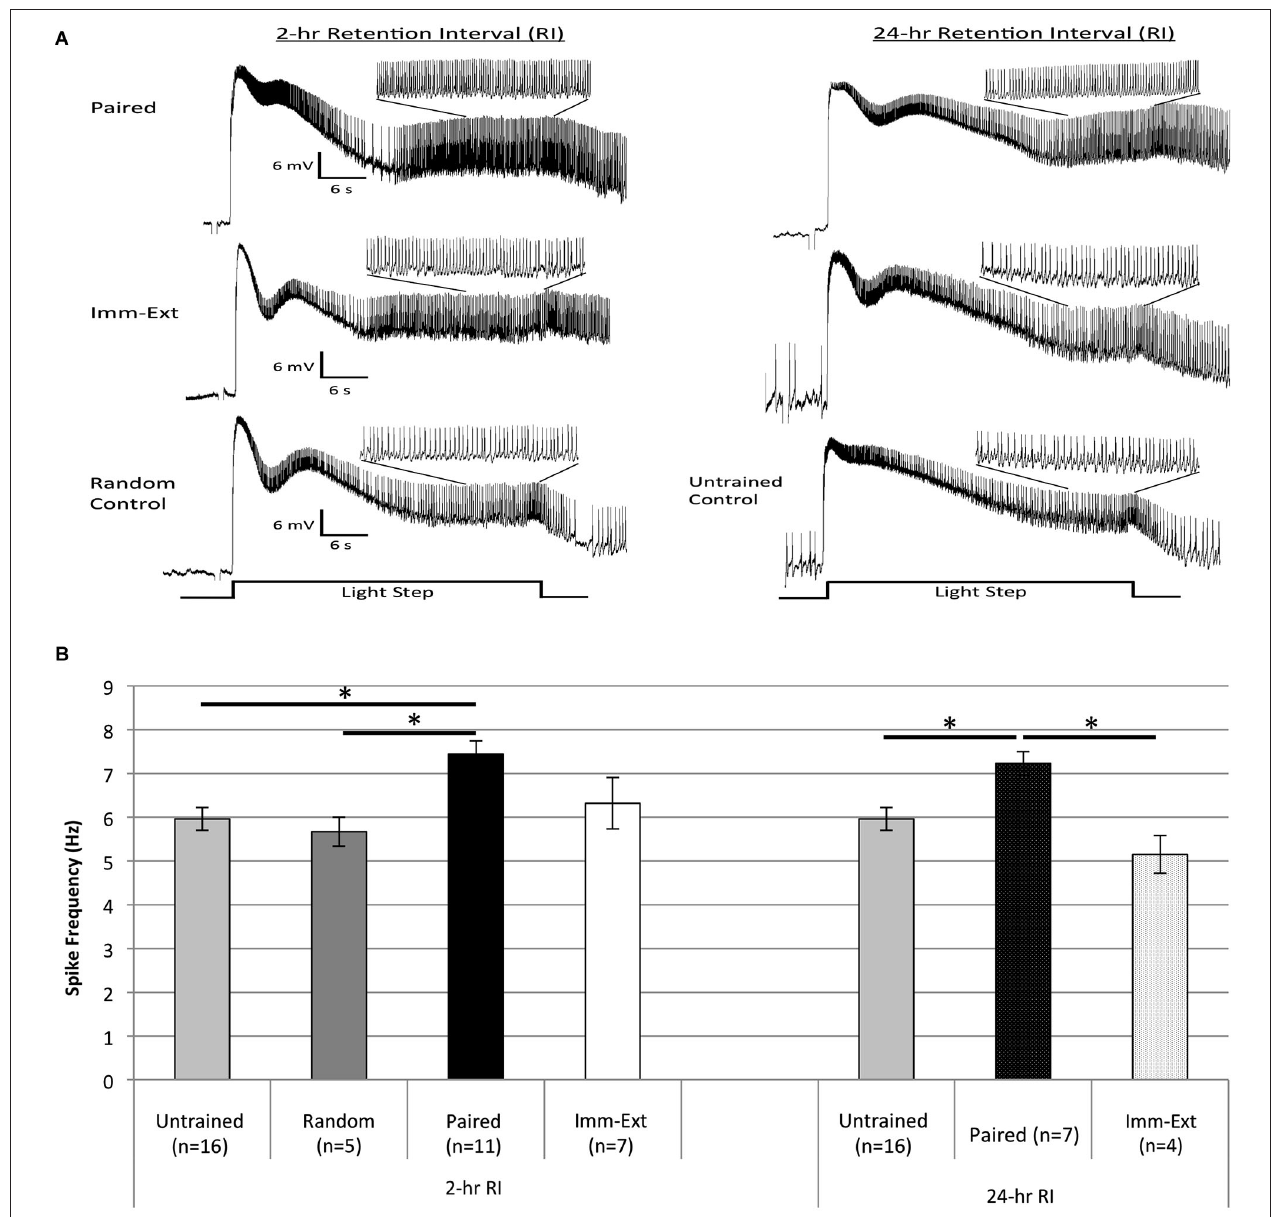
( Imm-Ext group) slightly reduced the pairing-produced increases in spike frequency at the 2-h RI. By the 24-h RI, the extinction-produced spike frequency reduction was greater and statistically significant. (B) Summary spike frequency data for trained cells and control cells during LSs 1 and 2. Spike frequencies were recorded over the last 10 s of each 30 s LS. Paired conditioning increased Type B cell spike frequency during LSs 1 and 2 above Untrained and Random (non-associative) control cells, which failed to differ. Immediate extinction (Imm-Ext) significantly reduced this increased spike frequency at the 24-h RI. No significant differences were found between Imm-Ext cells and control cells at either the 2-, or 24-h RIs. Error bars are ± S.E.M and significant p values ( p ’s < 0.05) are denoted by an asterisk.